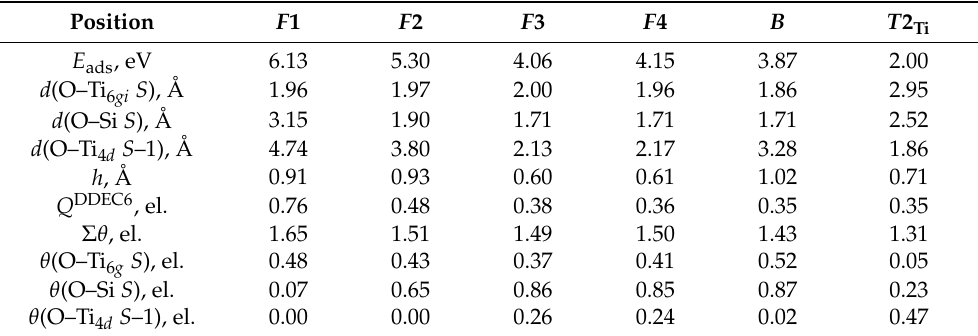
Table 2. Adsorption energy of oxygen ( E ads ) on the Ti 5 Si 3 (0001) TiSi surface, distance between oxygen and the nearest atoms of the substrate ( d (O–X)), height of oxygen relative to the surface layer ( h ), charge transfer to oxygen atom ( Q ) and overlap population for O–X bonds ( θ ). Position F